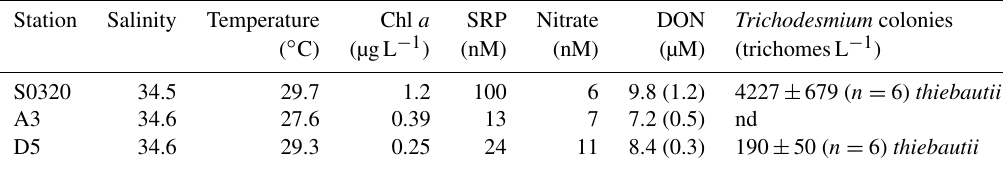
Table 1. Environmental conditions of the three stations’ surface water. nd: not determined. Station